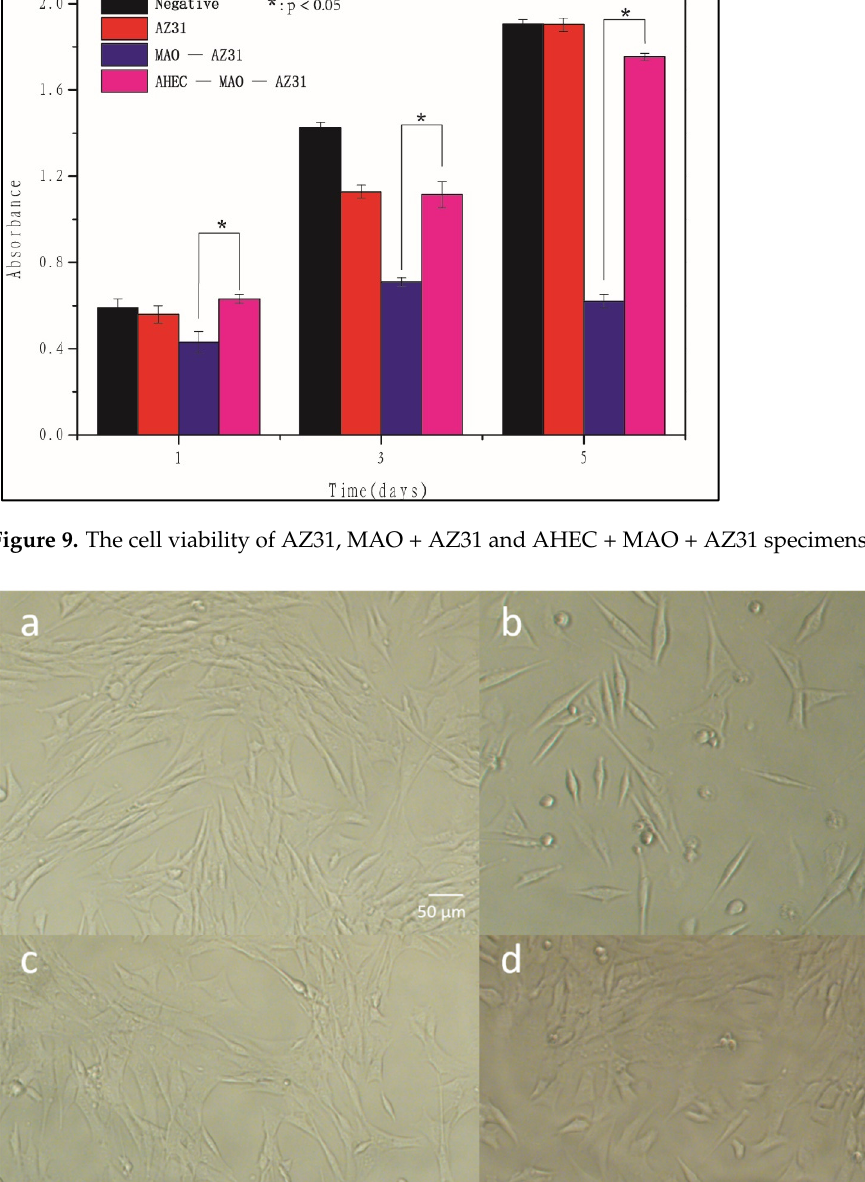
10 of 13 Figure 8. Long-term soaking diagram of each group. The red arrows indicate corrosion points. Scale bar = 5 mm. 3.3. Cytotoxicity Test 3.3.1. CCK-8 Test The toxicity of each group to MC3T3-E1 cells was determined by an indirect assay. Figure 9 shows the changes in the cell activity over time. The pure AZ31 magnesium alloy